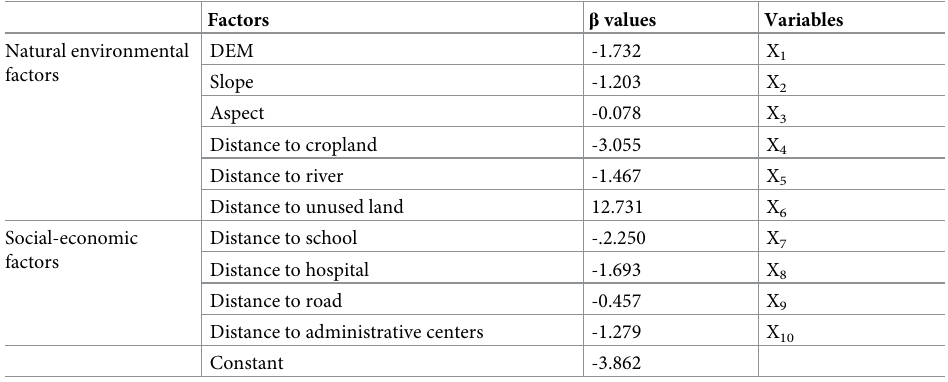
Table 2. Coefficients of the driving factors in the logistic regression